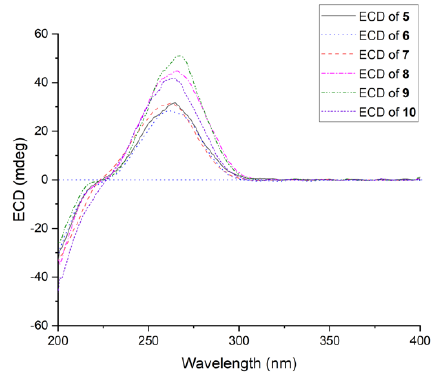
Figure 8. Experimental ECD of compounds 5 – 10 .